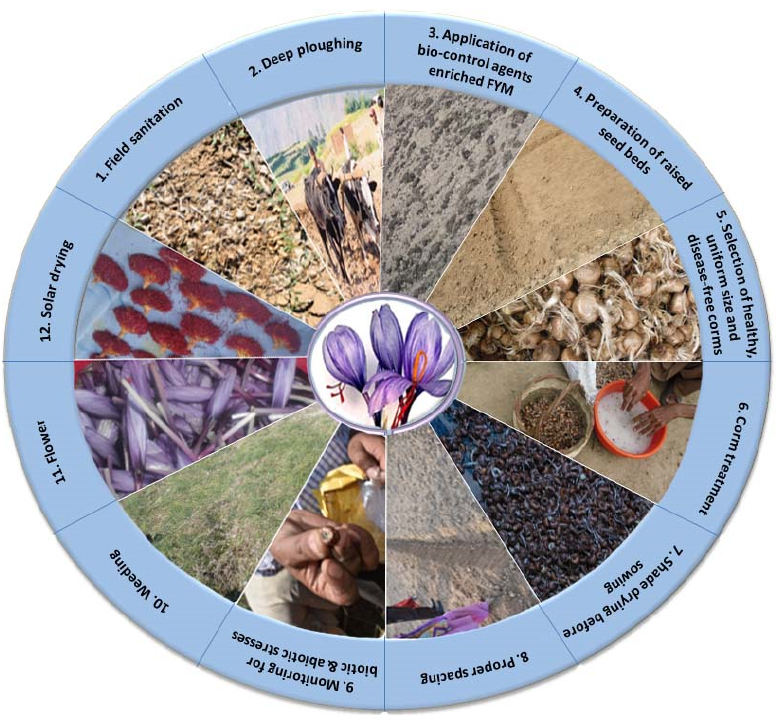
Figure 4. Integrated disease management (IDM) module for corm rot of saffron.